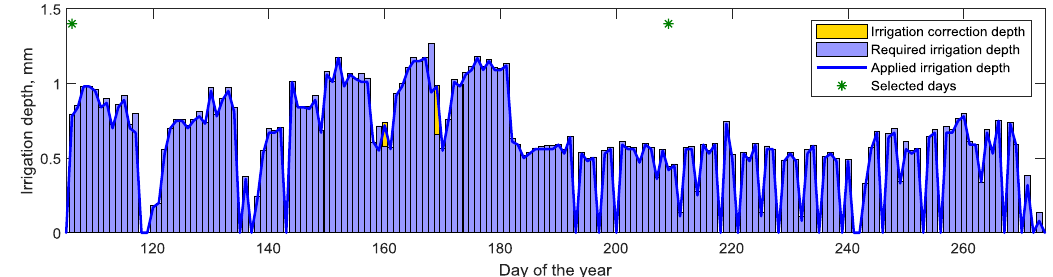
Figure 6. Irrigation scheduling with the smart photovoltaic irrigation manager (SPIM) and RESSIM management for a whole irrigation season.